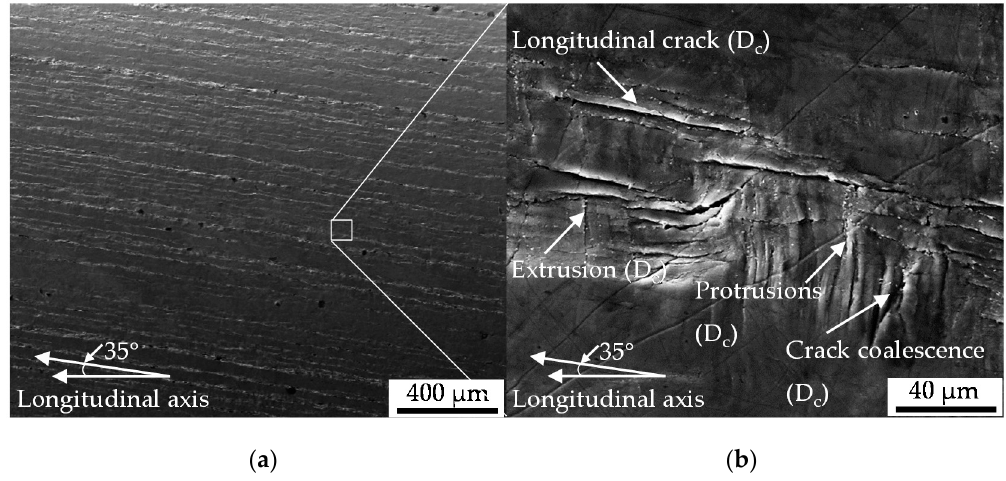
Figure 8. ( a ) Overview of sample surface after cyclic torsional load path with longitudinal cracks evolving at sample surface in axial direction; ( b ) interacting different types of cyclic damage (D c ).